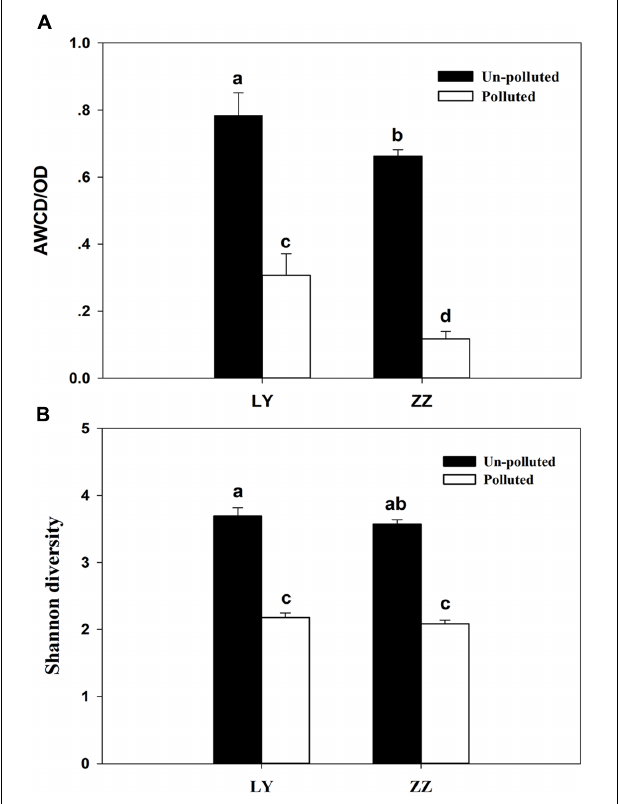
FIGURE 1 | Average well-color development (AWCD; A) and (B) Shannon diversity of soil microbial community. LY and ZZ mean Liuyang and Zhuzhou City, respectively. Error bars are ± standard deviation ( n = 5). Columns marked with the same lower-case letter were not significantly different based on Fisher’s protected LSD test ( P <